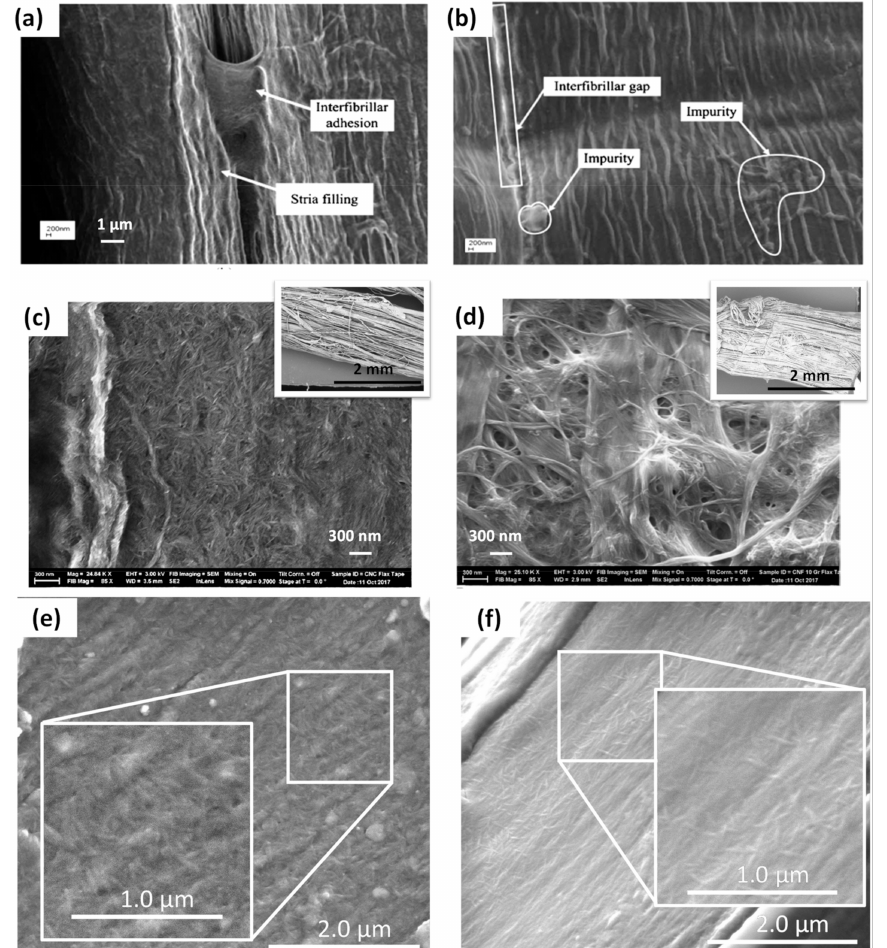
Figure 21. SEM Images of ( a , b ) nanocellulose treated hemp fibres, ( c ) CNC and ( d ) CNF 100G treated flax tapes, ( e ) CNC and ( f ) xyloglucan (XG)/CNC modified flax woven fabric (reprinted with permission from Dai and Fan (2013) [29], Ghasemi et al. (2018) [90] and Doineau et al. (2020)